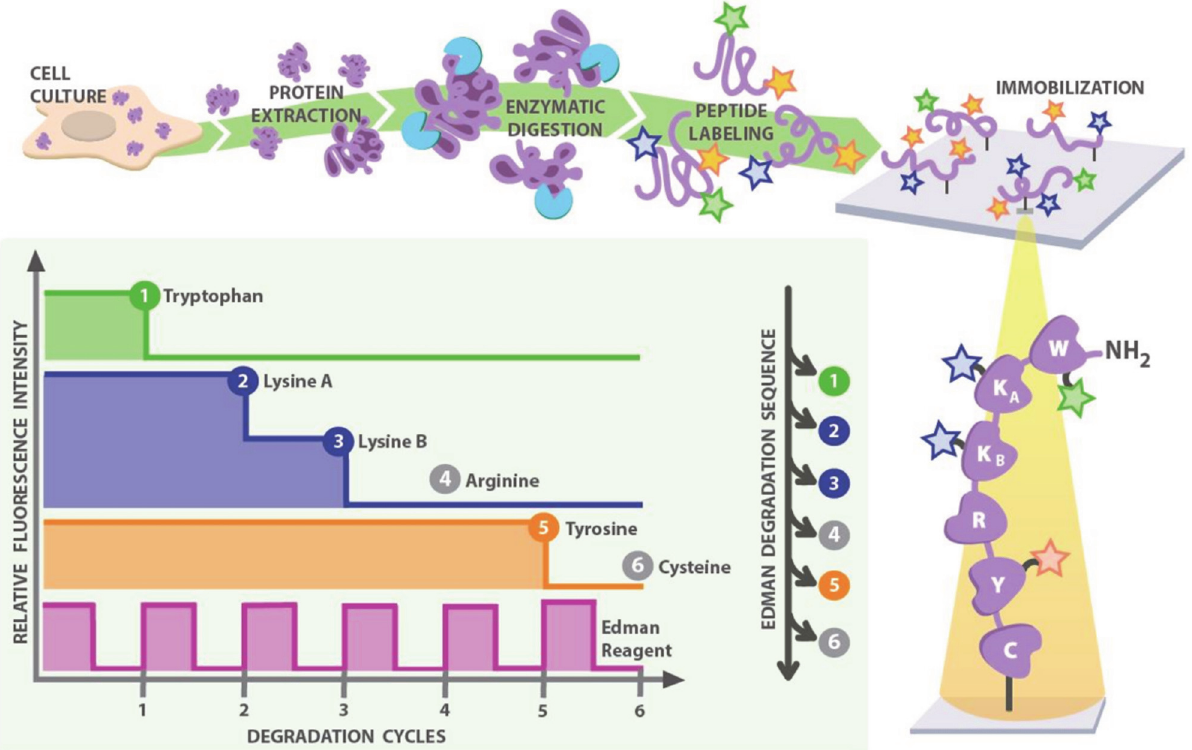
Fig 1. A strategy for single-molecule peptide sequencing. Proteins are extracted and digested into peptides by a sequence-specific endo-peptidase. All occurrences of particular amino acids are selectively labeled by fluorescent dyes (e.g., yellow for tyrosine, green for tryptophan, and blue for lysine residues), and the peptides are surface immobilized for single-molecule imaging (e.g. by anchoring via cysteine). The peptides are subjected to cycles of Edman degradation; in each cycle, a fluorescent Edman reagent (pink trace) couples to and removes the most N-terminal amino acid. The step drop of fluorescent intensity indicates when labeled amino acids are removed, which in combination with the Edman cycle completion signal, gives the resulting fluorosequence (e.g., “ WKKxY ... ” ). Matching this partial sequence to a reference protein database identifies the